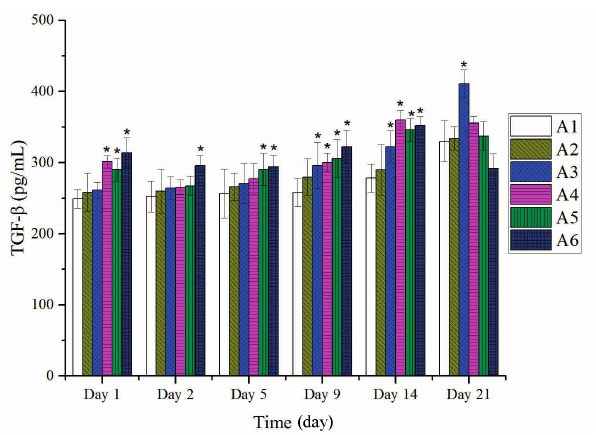
Figure 7. Expressions of TGF- β in tissues after treatment with BBO in rats. Values are expressed as mean ± S.D. ( n = 4 animals). * : p < 0.05 vs.